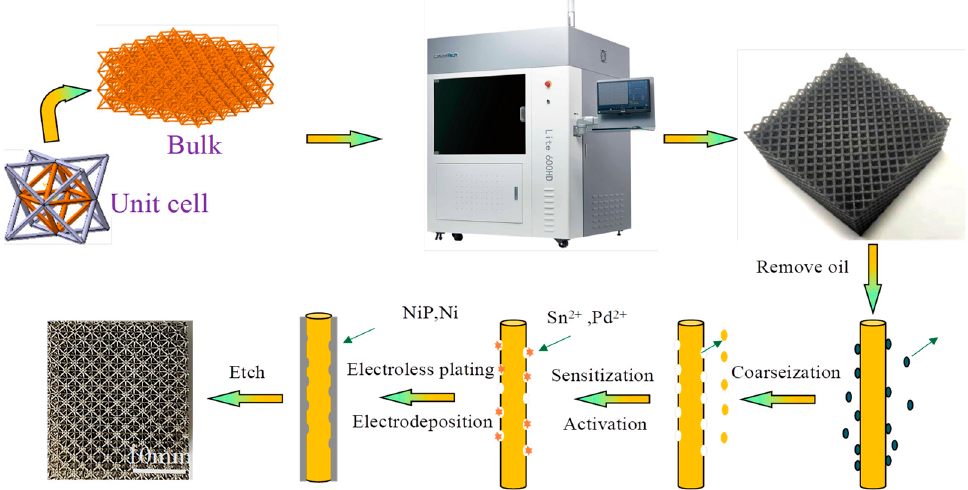
Figure 1. Schematic of the fabrication process for hollow nickel lattices. The electrodeposition solution was based on commercial nickel sulfonate (AR). To obtain a better structural uniformity, the cathode sample was placed between the two nickel anodes, and electrodeposition was carried out at 50 °C and pH 3.5~4.5. A double pulse power supply was used with a current density of 2.0 A/dm 2 , and the pulse frequency and the duty cycle were set up as 1000 Hz and 1:5, respectively.